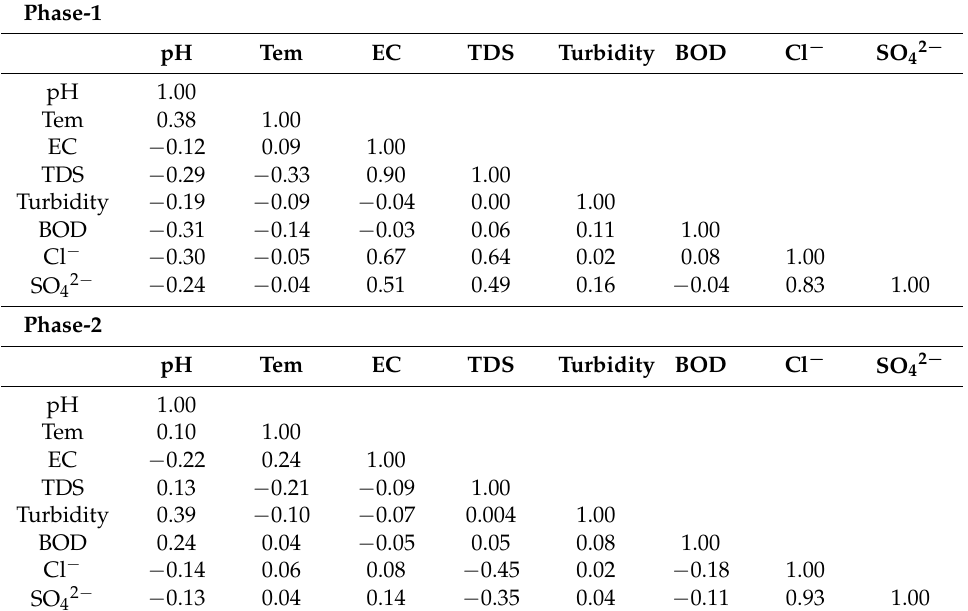
Table A1. Correlation matrix for physico-chemical parameters in the two